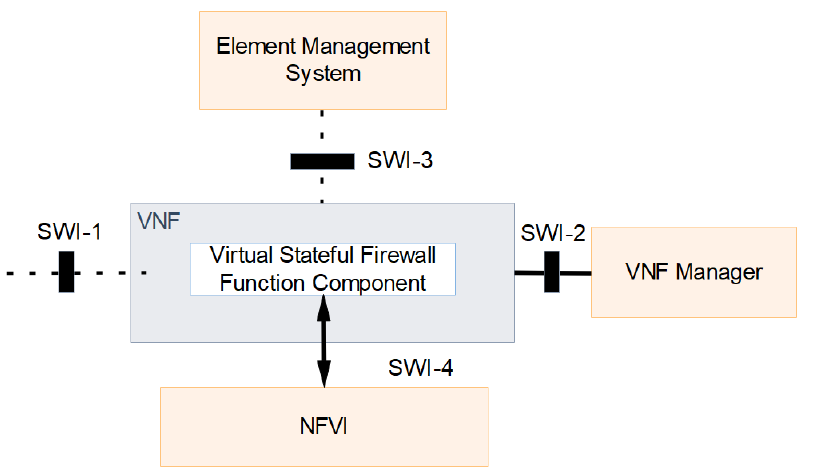
Figure 4. Stateful Firewall VNF